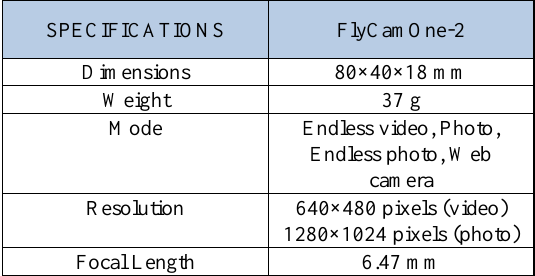
Table 6. Technical specifications of the